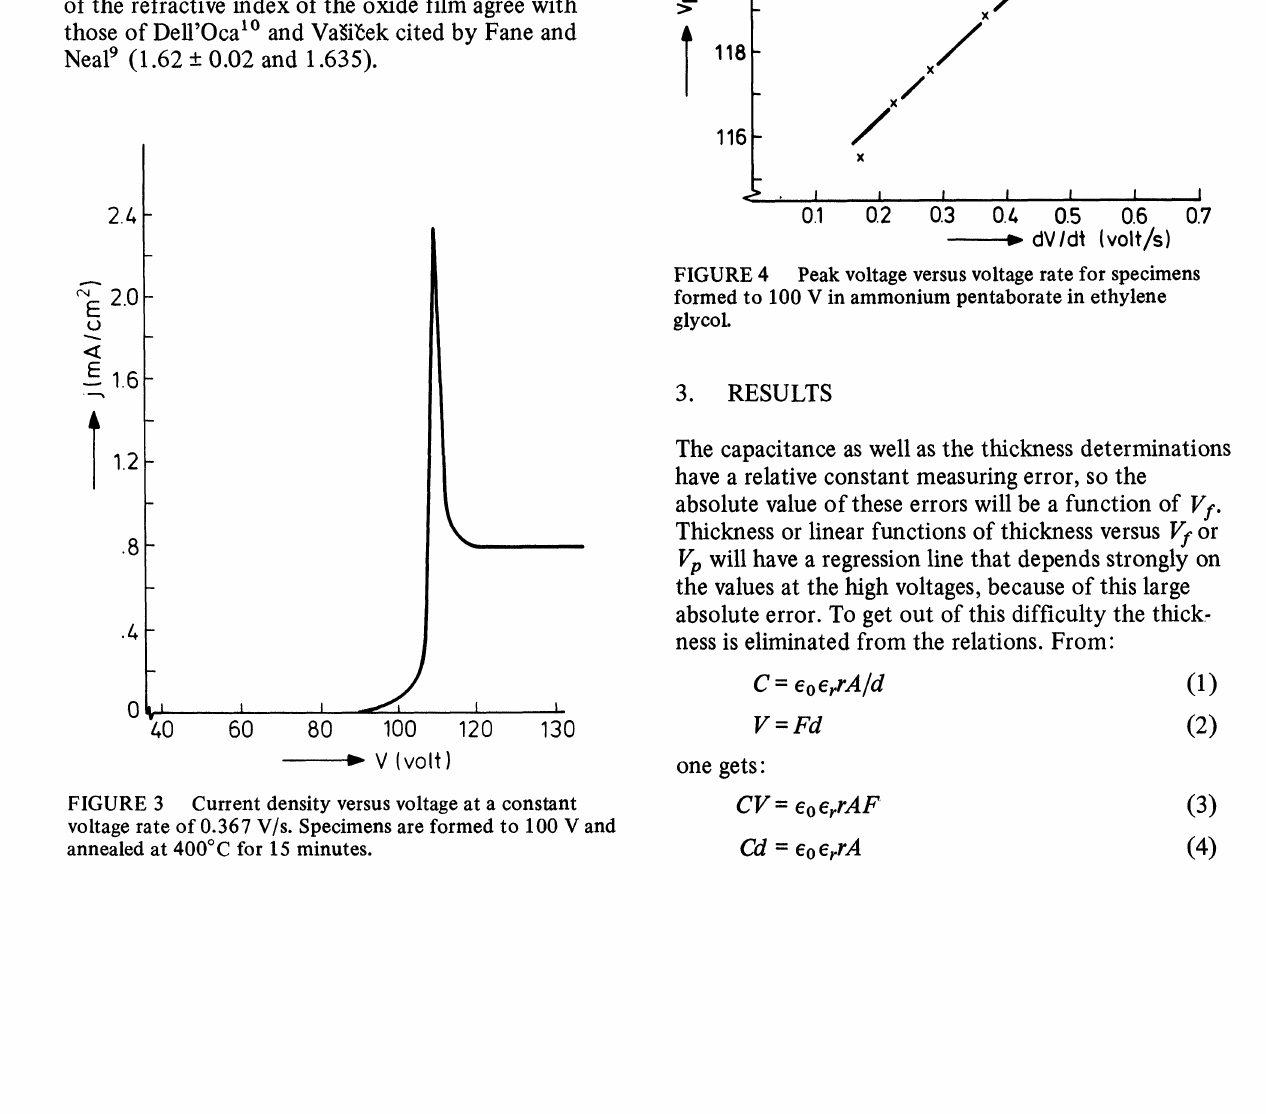
Peak voltage versus voltage rate for specimens formed to 100 V in ammonium pentaborate in ethylene